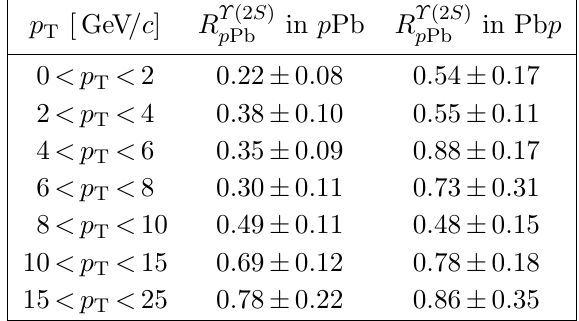
Table 14 . (cid:7) (2 S ) nuclear modi(cid:12)cation factor, R (cid:7) (2 S ) over y (cid:3) in the range 1 : 5 < y (cid:3) < 4 : 0 for p Pb and (cid:0) 5 : 0 < y (cid:3) < (cid:0) 2 : 5 for Pb p .